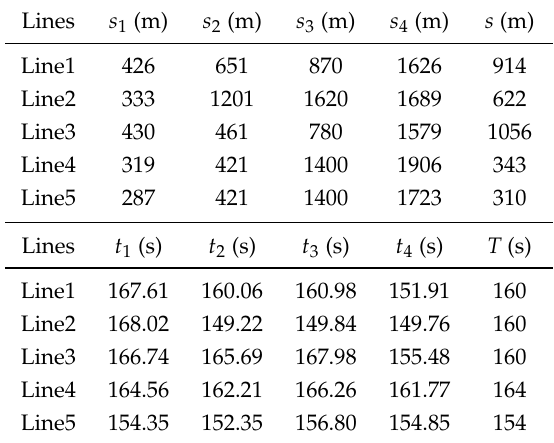
Table 6. Four critical states s 1 – s 4 , the corresponding running time t 1 – t 4 and the coasting point s of different